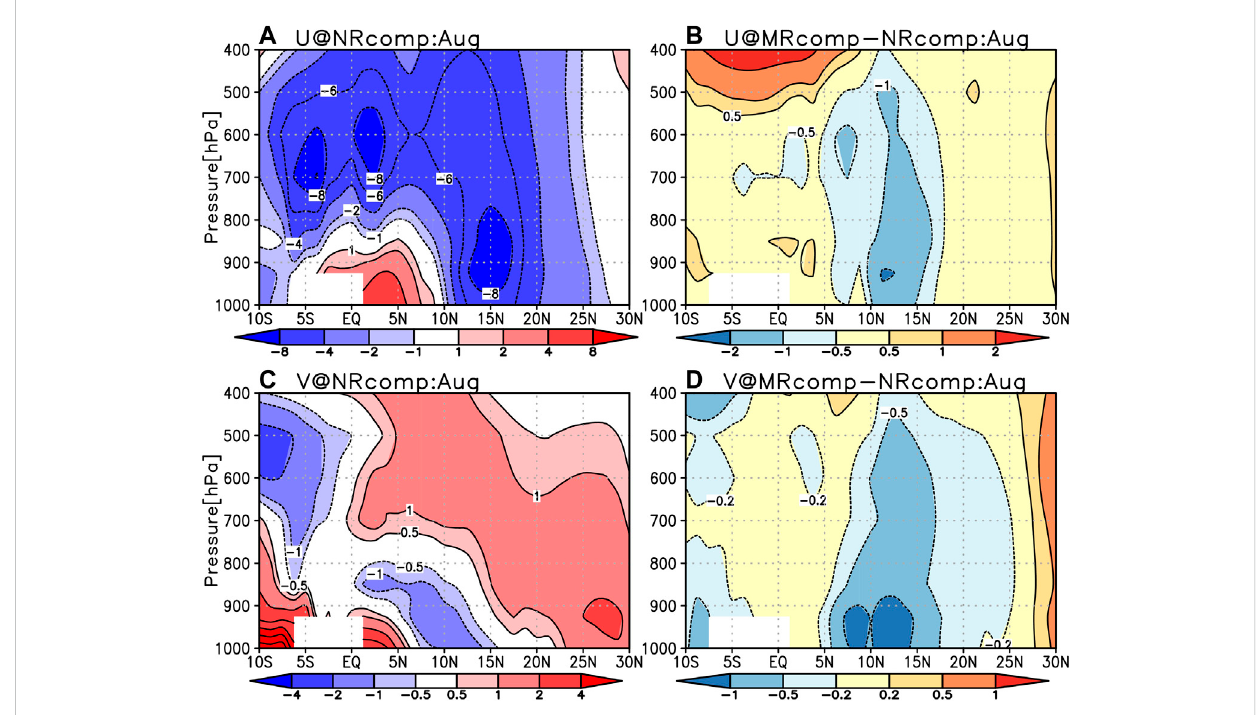
FIGURE 6 Composited vertical section at 80 ° W for easterly (A, B) and northerly (C, D) winds in August. The left panels are wind speed in NRcomp, while differences (MRcomp – NRcomp) are shown in the right panels.